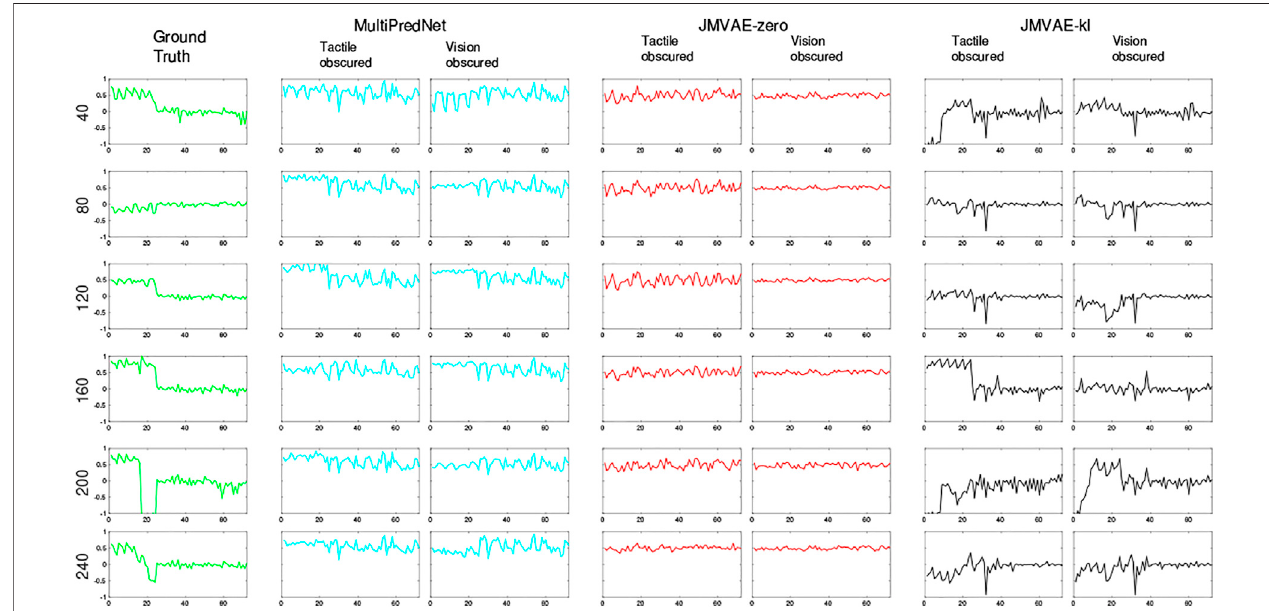
FIGURE13| Exampletactileinformationcapturedfromthewhiskerarrayatpointofpeakprotractionatthesamplepointsinthetestsetasindicatedbythenumber ontheleftofeachrow.The fi rst24valuesineachsampleistheprotractionangleofeachwhisker( θ whisk )inthearraywiththeremaining48valuesindicatingthemagnitude ofde fl ectionexperiencedbyeachwhiskerinthe x and y dimensions(referto Figure1 fordescription).AsinFigure12,theplotsineachrowtotherightofthegroundtruth were reconstructed by the different trained models under test during the 2 drop-out conditions. The JMVAE-kl model performed best at tactile reconstruction in all conditions(see Figure8 )asisclearfromtheseindicativeexamples.BothMultiPredNetandJMVAE-zerofailedtoaccommodatethesystematicoff-setinde fl ectionangle which JMVAE-kl has, i.e., nominally zero in the last 48 values of reconstructed vector.